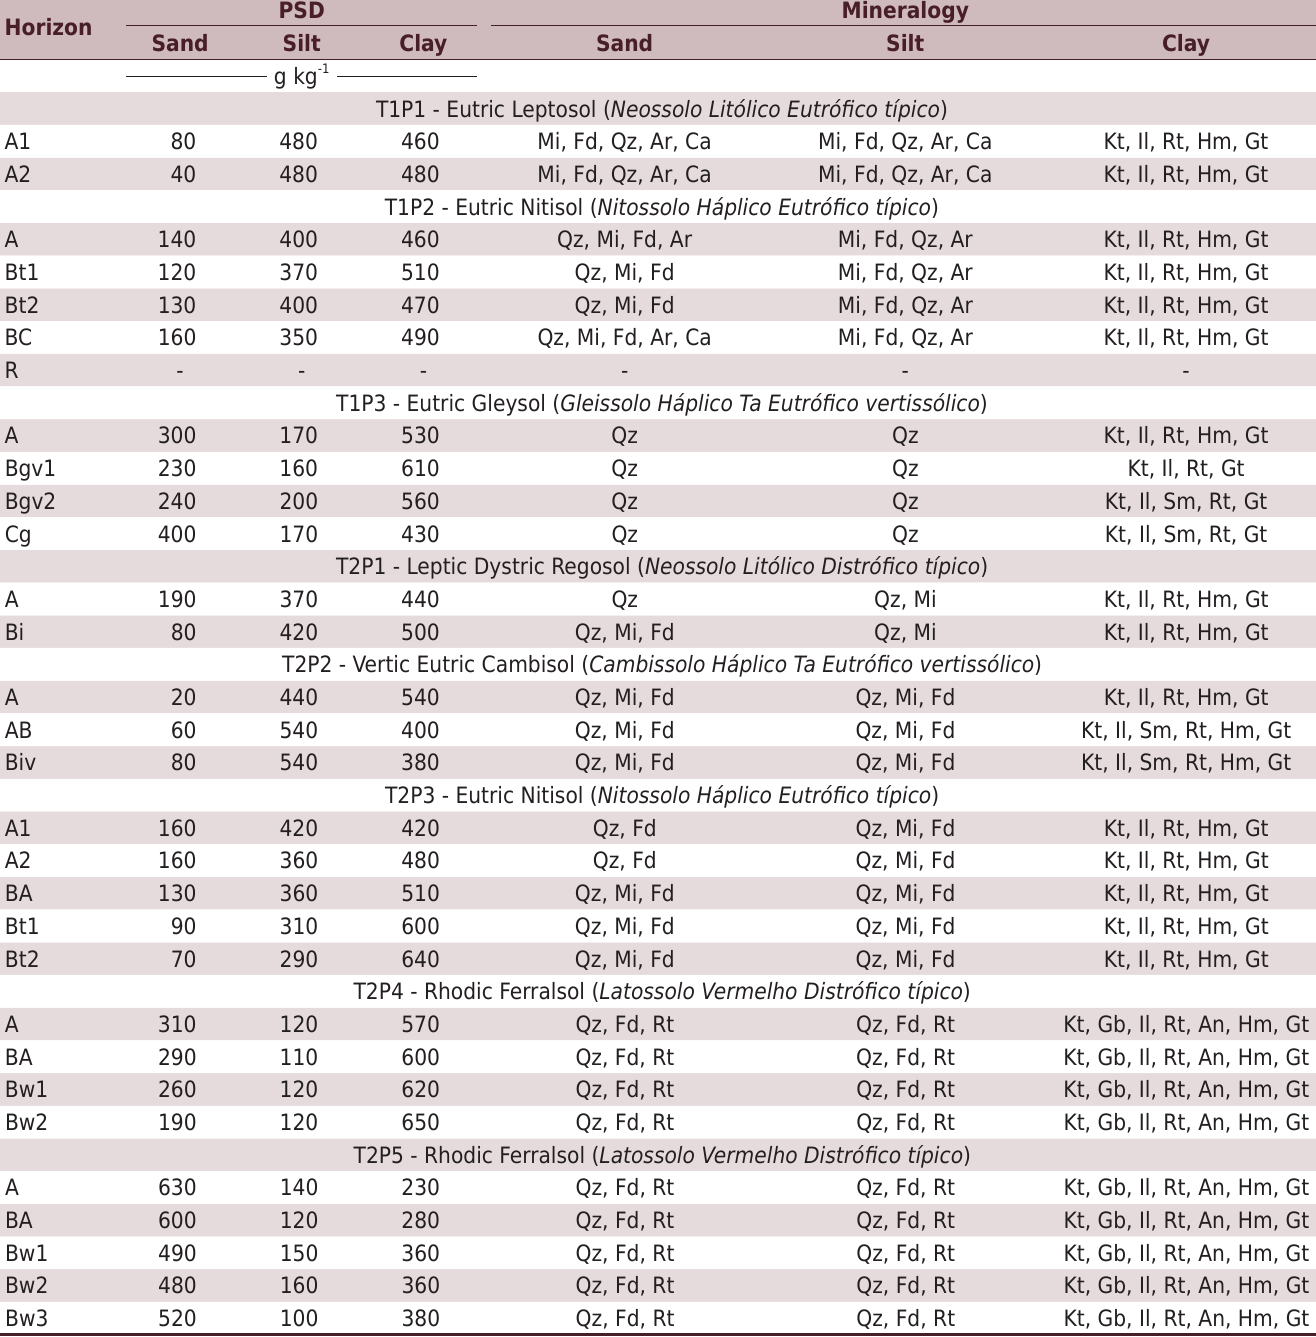
Table 2. Particle-size distribution (PSD) and mineralogical constituents of soil profiles collected at two lithotoposequences located in the Montes Claros (MG, Brazil) microregion PSD Mineralogy Horizon Sand Silt Clay Sand Silt